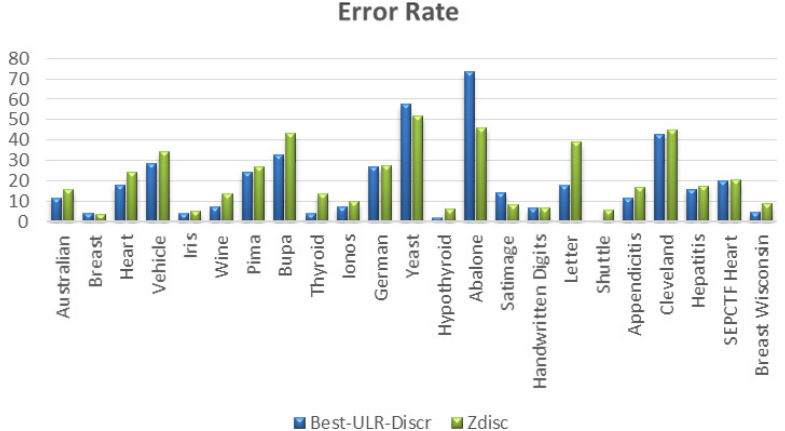
Fig. 6. Comparing error rates for Best-ULR-Discr and ZDisc. Table 9 exhibits the results of the comparison of the runtime between ULR-Discr and ZDisc. The comparison is done more precisely with ULR-Discr using the Pearson coe±cient, because the latter has the best response time. So, there is really no need to